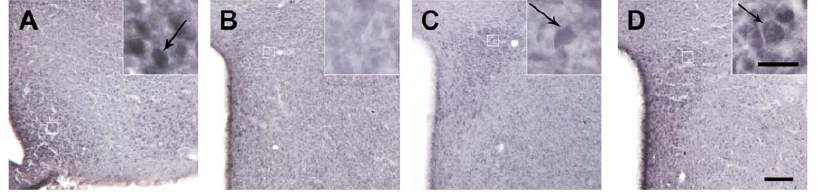
Figure 7. Ghrelin binding to the compact part of the PVN is scarce. This figure shows representative photomicrographs of brains sections subjected to a ghrelin binding assay (see Material and Methods for details), at low and high magnification (inserts). Purple/Black signal indicates specific binding of ghrelin. Panel A shows an internal positive control of the assay in which positive ghrelin binding to cells located in the ARC and to the ventrolateral subdivision of the VMH (vlVMH) is observed, when brain section are incubated with 1 m g/ml of ghrelin. Panel B shows the PVN level for a negative control, where no exogenous ghrelin was added. Panels C and D show positive ghrelin binding to cells located in the PVN, in brain section previously incubated with 0.1 or 1 m g/ml of ghrelin, respectively. Inserts in each image show high magnification of areas marked in low magnification images. Arrows point to labeled cells. Scale bars, 100 m m (low magnification), 10 m m (high magnification).